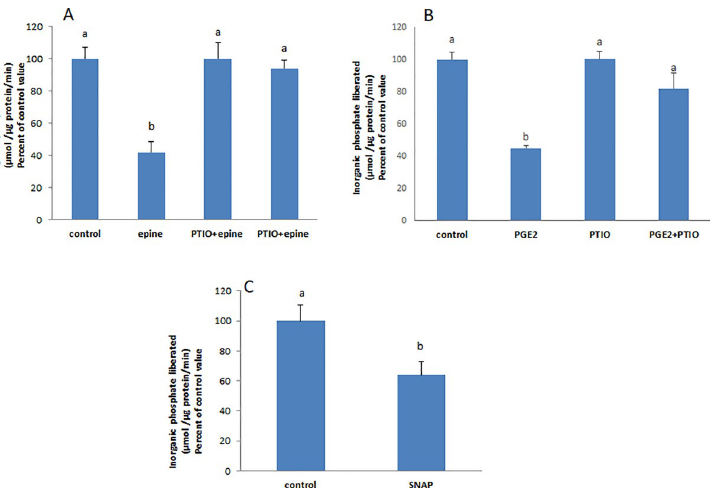
Fig 4. Epinephrine and PGE2 induce NO production. The effect of (A) epinephrine and (B) PGE2 did not appear in cells pre-treated for 20min with PTIO (30 μ M), a scavenger of NO. (C) SNAP (2 μ M, 20min) a NO donor caused a significant inhibition of the ATPase. Values are means ± SEM of at least 3 observations. Bars not sharing a common letter are considered significantly different from each other at P <